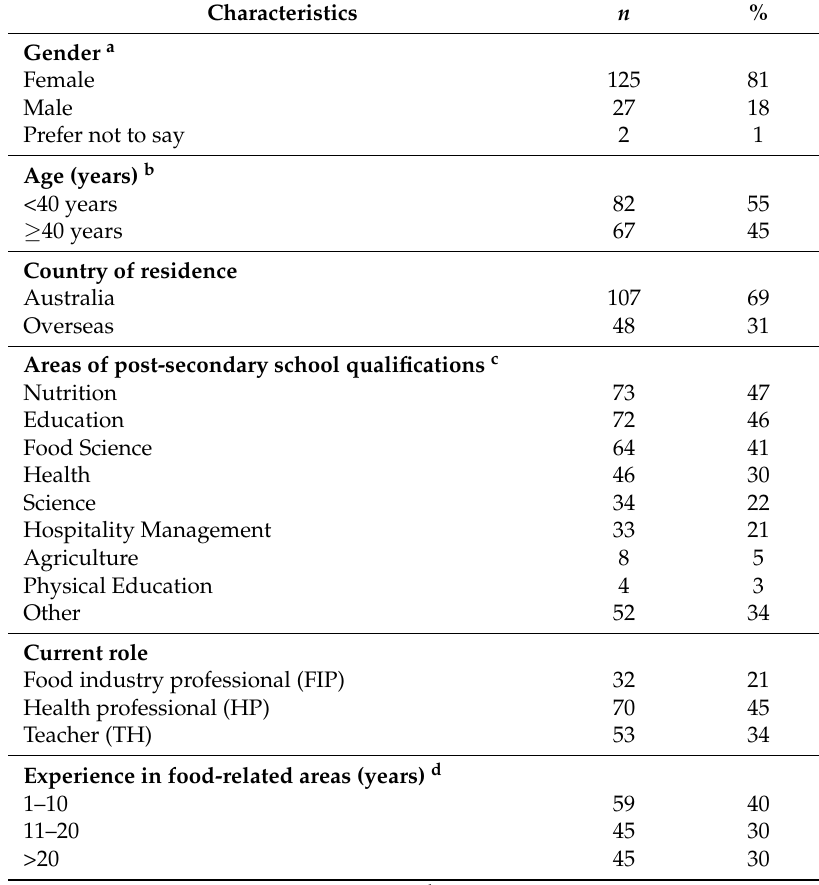
Table 1. Respondents’ demographic and professional